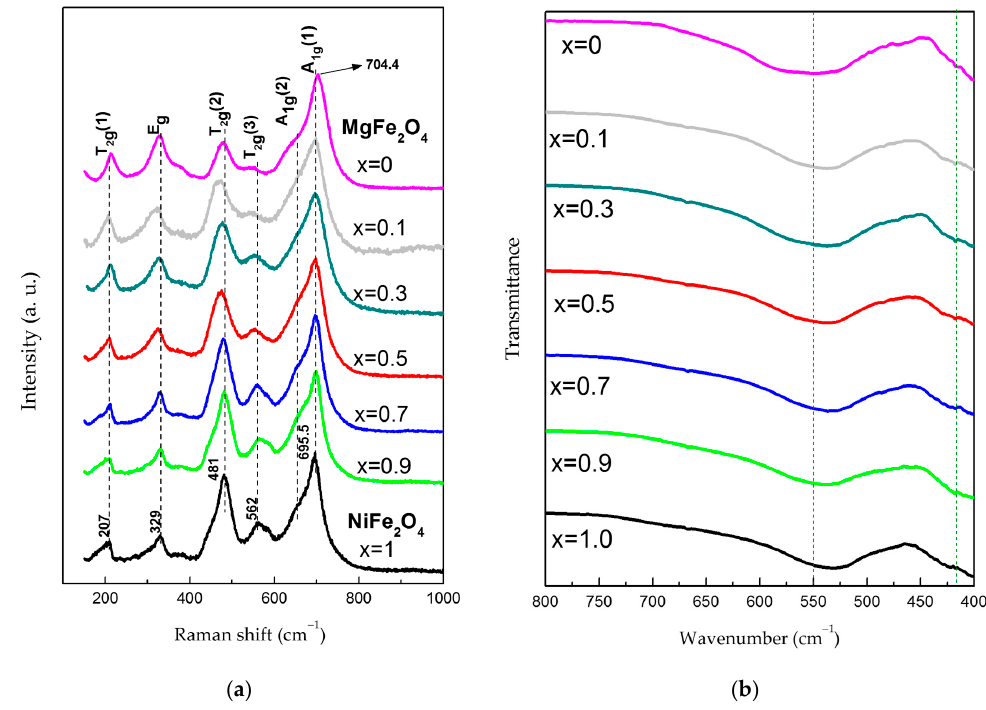
Figure 3. ( a ) Raman spectra and (b) FTIR spectra of synthesized Ni x Mg 1-x Fe 2 O 4 (0 ≤ x ≤ 1).